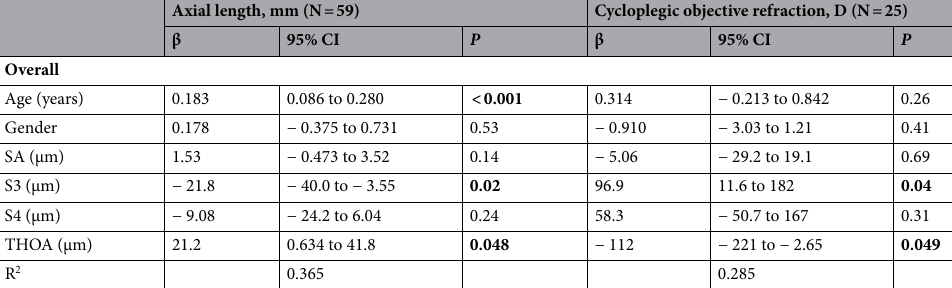
Table 4. Results of multiple regression analyses to estimate the association between myopia and intraocular higher order aberrations (evaluated with natural pupillary diameters, average value φ = 6.1 mm). D diopters, SA spherical aberration, S3 3rd-order aberrations, S4 4th-order aberrations, THOA sum of the 3rd- to 6th-order aberrations, 95% CI 95% confidence interval, β coefficient Two multiple regression models were used. Axial length or cycloplegic objective refraction was used as the outcome variable. P < 0.05 are highlighted. For gender, boys were numbered 1 and girls were numbered 0.